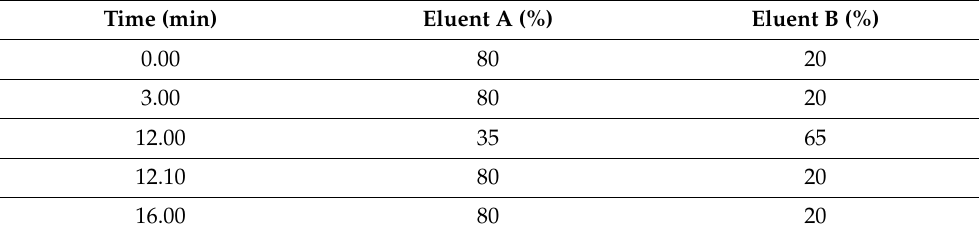
Table 1. Gradient conditions of the high-performance liquid chromatography (HPLC) method with eluent A (phosphate buffer containing triethylamine, pH 3.0) and eluent B (methanol), flow rate 0.4